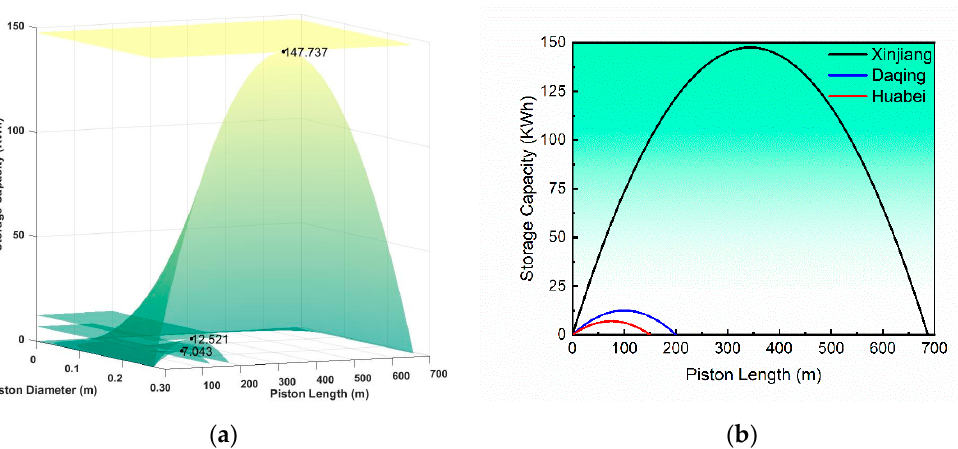
Figure 3. Storage capacity of the gravitational potential energy and its variation with piston length in the three selected oilfields. ( a ) Storage capacity of the gravitational potential energy in the three oilfields. ( b ) Variation of the storage capacity of the gravitational potential energy with piston length in the three oilfields.